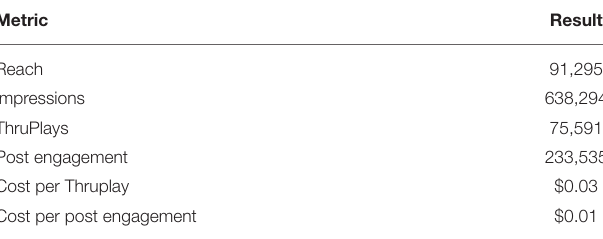
TABLE 2 | Facebook